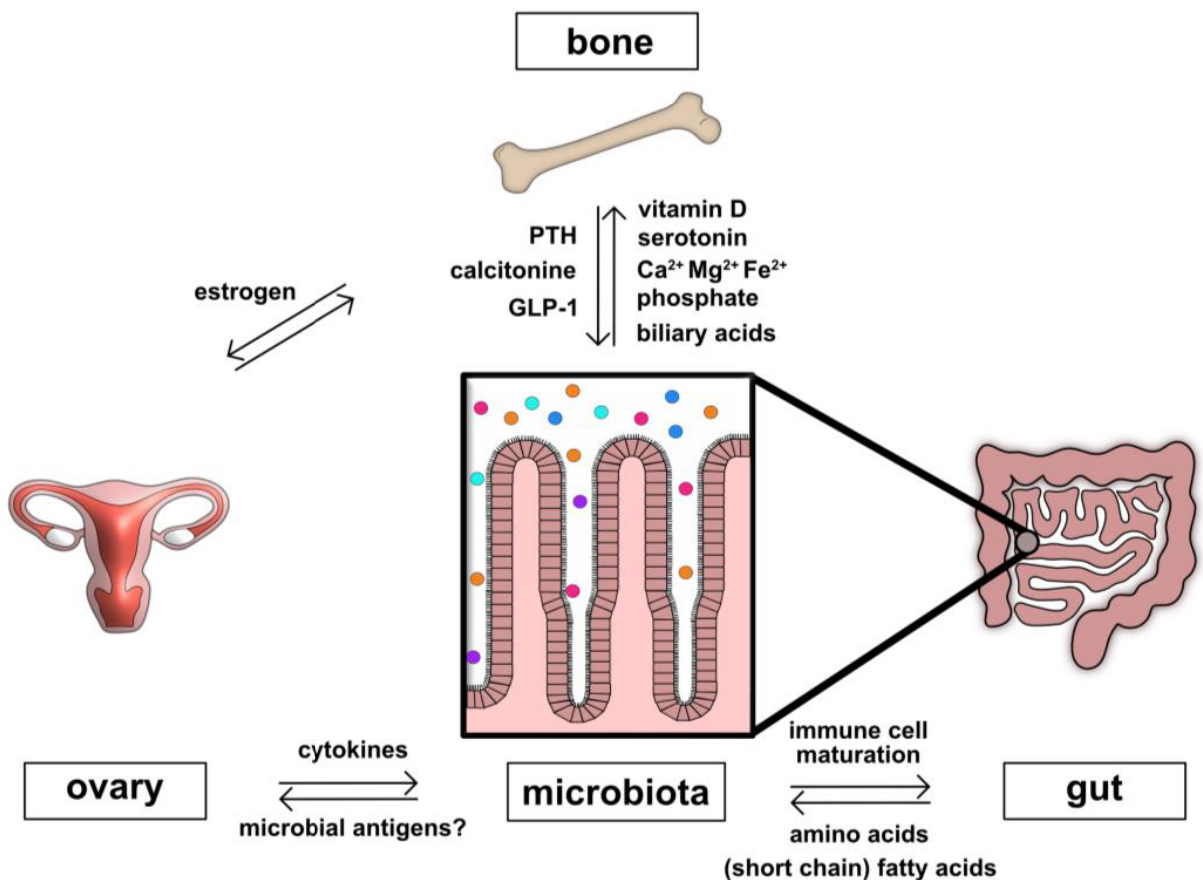
Figure 1. Influence of gut microbiota on physiological circuits regulating bone metabolism. Intestinal microbiota can interfere with several factors and signaling pathways regulating physiological bone homeostasis and metabolism. For example, calcitonin and PTH (hormones which exert opposite effects on mineralization) require intestinal microbiota to exert their anabolic and catabolic ef- fects. Microbiota enzymatically activate estrogens, control cytokine production, and control im- mune cell differentiation, particularly Th17-Treg homeostasis. Intraluminal, microbiota-dependent amino acid and short chain fatty acid (SCFA) metabolism contributes (in part) to the regulation of these immune responses. Intestinal microbiota are crucial for the maintenance of the intestinal phys- iological barrier and electrolyte balance. Vitamin D is pivotal to establishing microbial diversity in the gut.